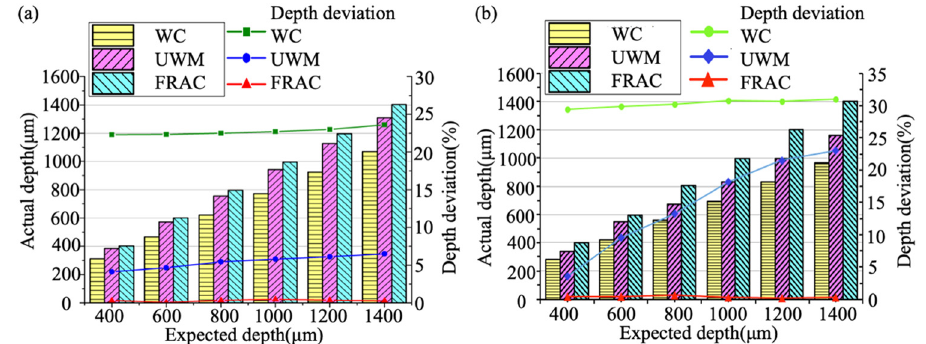
Figure 3: The measurement depth and depth deviation of blind holes: ( a ) tungsten steel electrode and ( b ) brass electrode ( frequency = 120 kHz, pulse width = 3 µs, current = 2.5, voltage = 90 V, gain coe ffi cient = 15 )